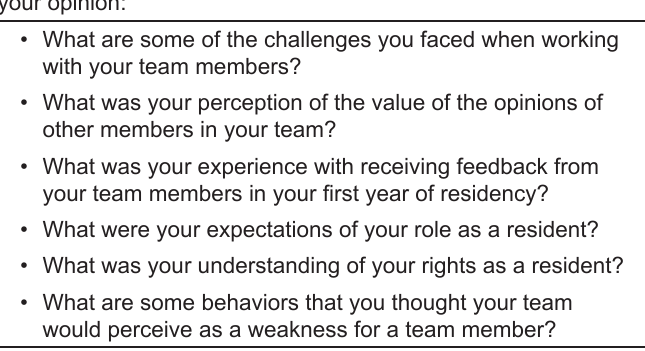
Table 1. Examples of interview questions asked of non-US international medical